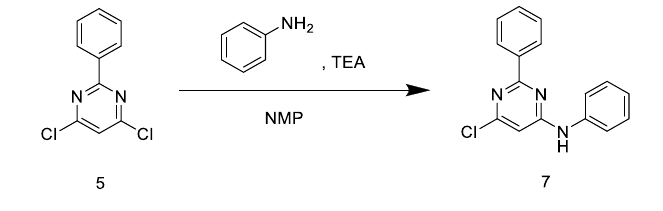
Scheme 2. The synthetic route of target compound 6 .